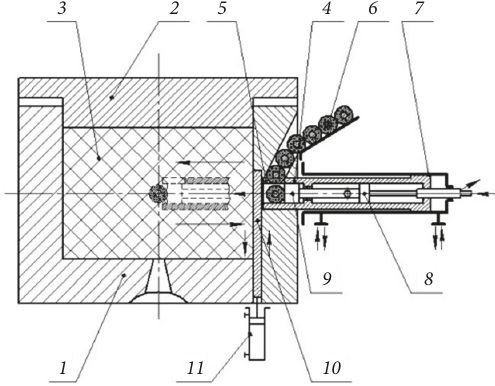
Figure 1: Scheme of an injection mold with an IS input device at a given volume coordinate of the polymer